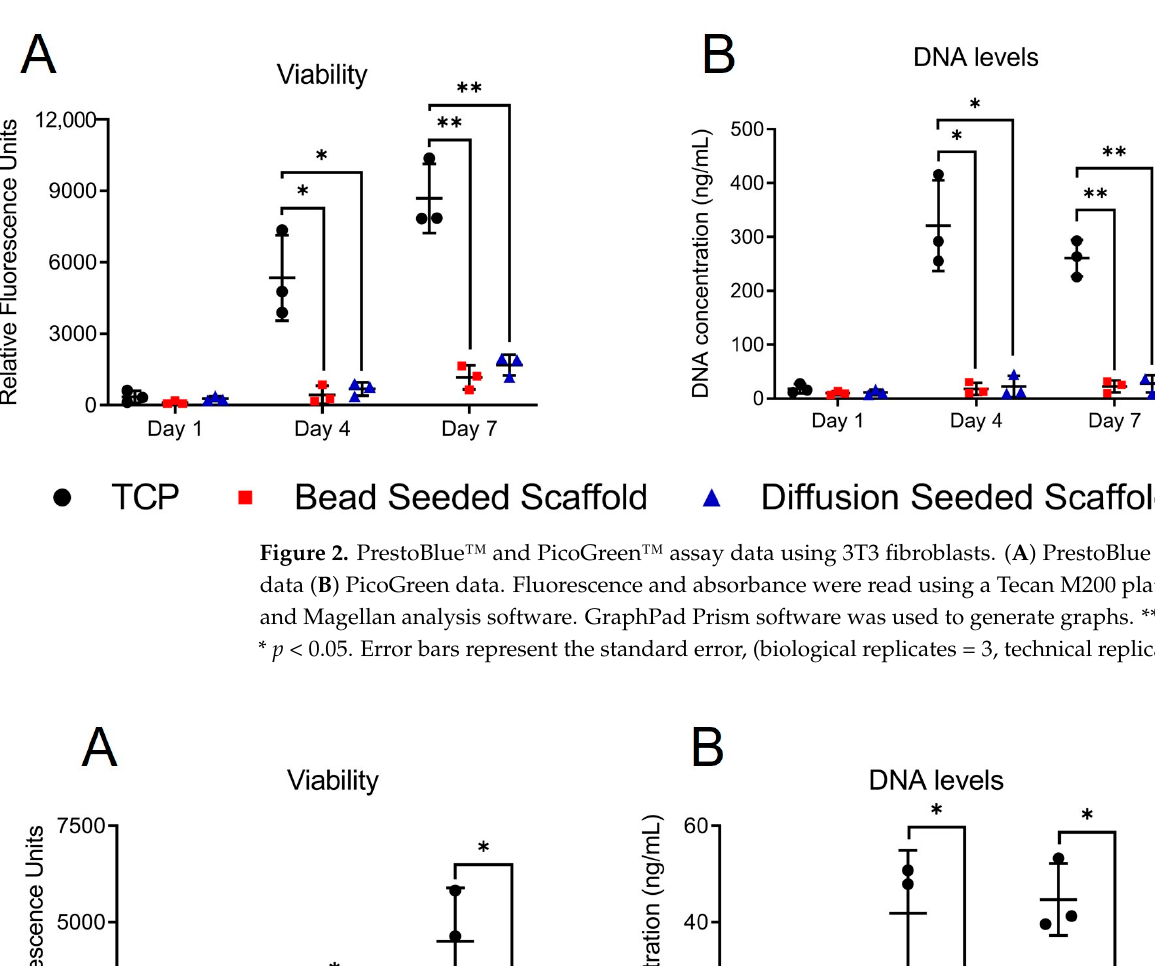
Figure 2. PrestoBlue™ and PicoGreen™ assay data using 3T3 fibroblasts. ( A ) PrestoBlue Viability data ( B ) PicoGreen data. Fluorescence and absorbance were read using a Tecan M200 plate reader and Magellan analysis software. GraphPad Prism software was used to generate graphs. ** p < 0.01, * p < 0.05. Error bars represent the standard error, (biological replicates = 3, technical replicates = 3).